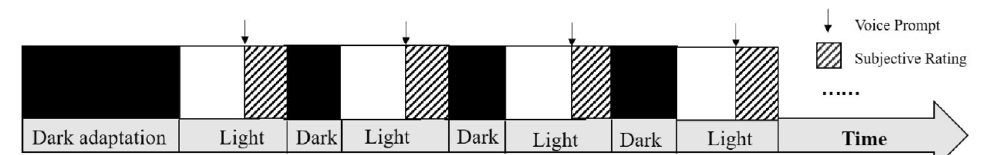
Figure 5. Testing sequence. Subjects were exposed to different lights one after another with a 2-min dark interval (< 0.01 lx). After light exposure, a brief voice (indicated by arrow) prompted participants to rate their current subjective feelings within 1 min under the same light